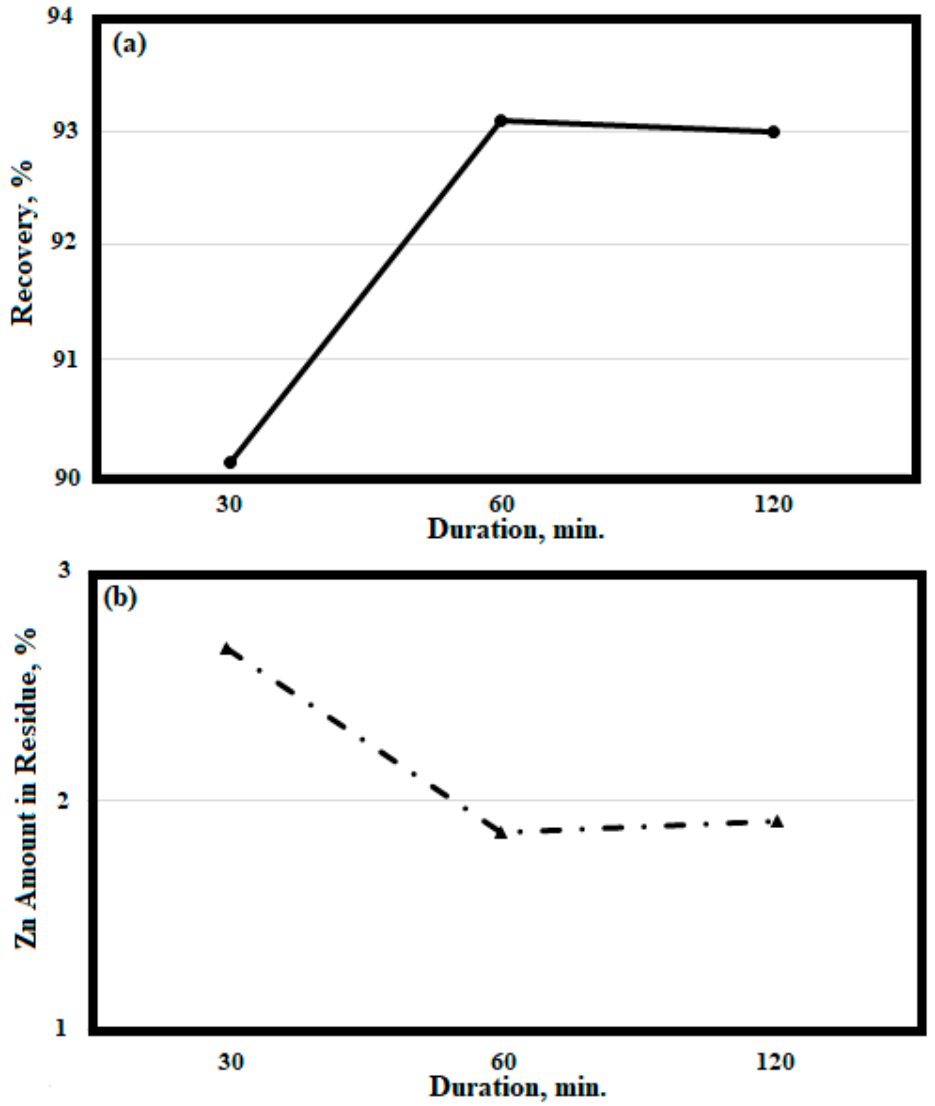
Figure 6. ( a ) Zn recovery of ambient condition experiments, ( b ) Zn amount in the residue (1100 °C various duration, Ar flow).